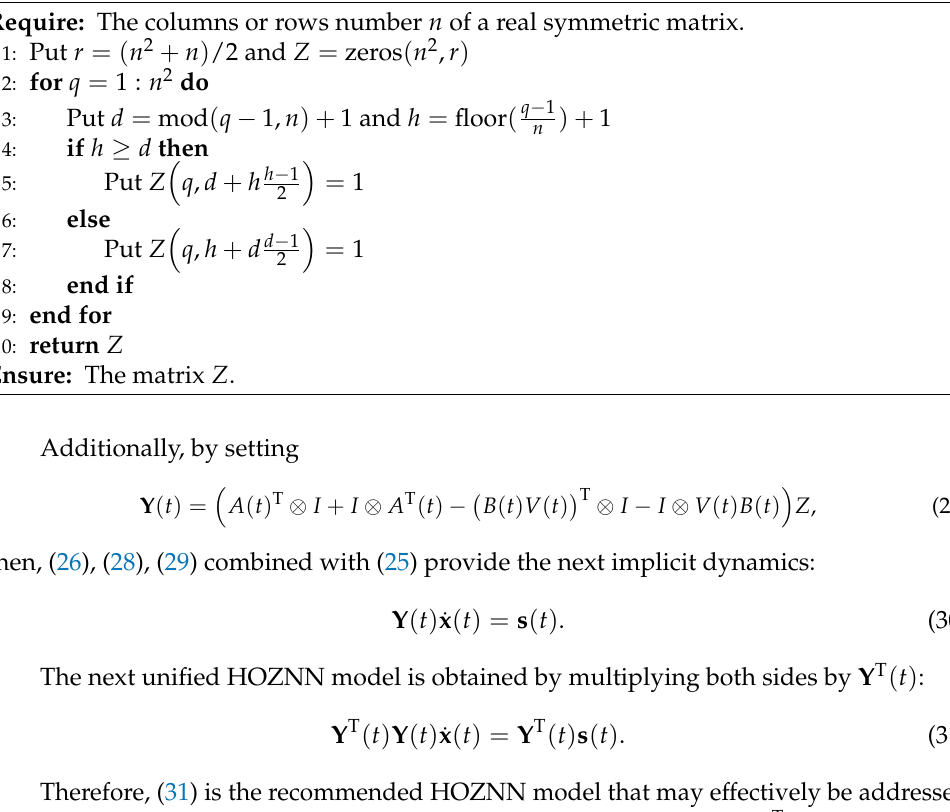
Algorithm 1 Calculation method for the operational matrix Z